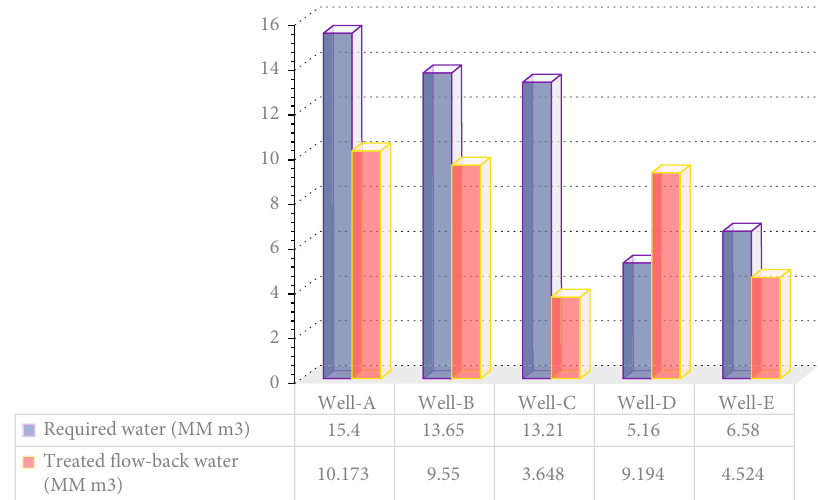
Figure 3: Comparison of treated fl ow-back water and fresh water in chemical recovery techniques. Table 4: Annual and daily saving water in chemical recovery